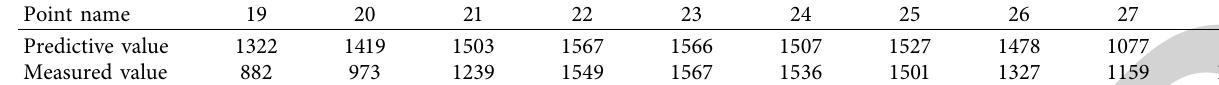
Table 1: East measured and expected sinking value (mm).